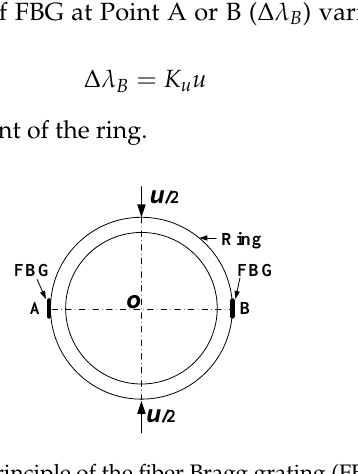
Figure 3. Drawing of principle of the fiber Bragg grating (FBG)-sensing ring.